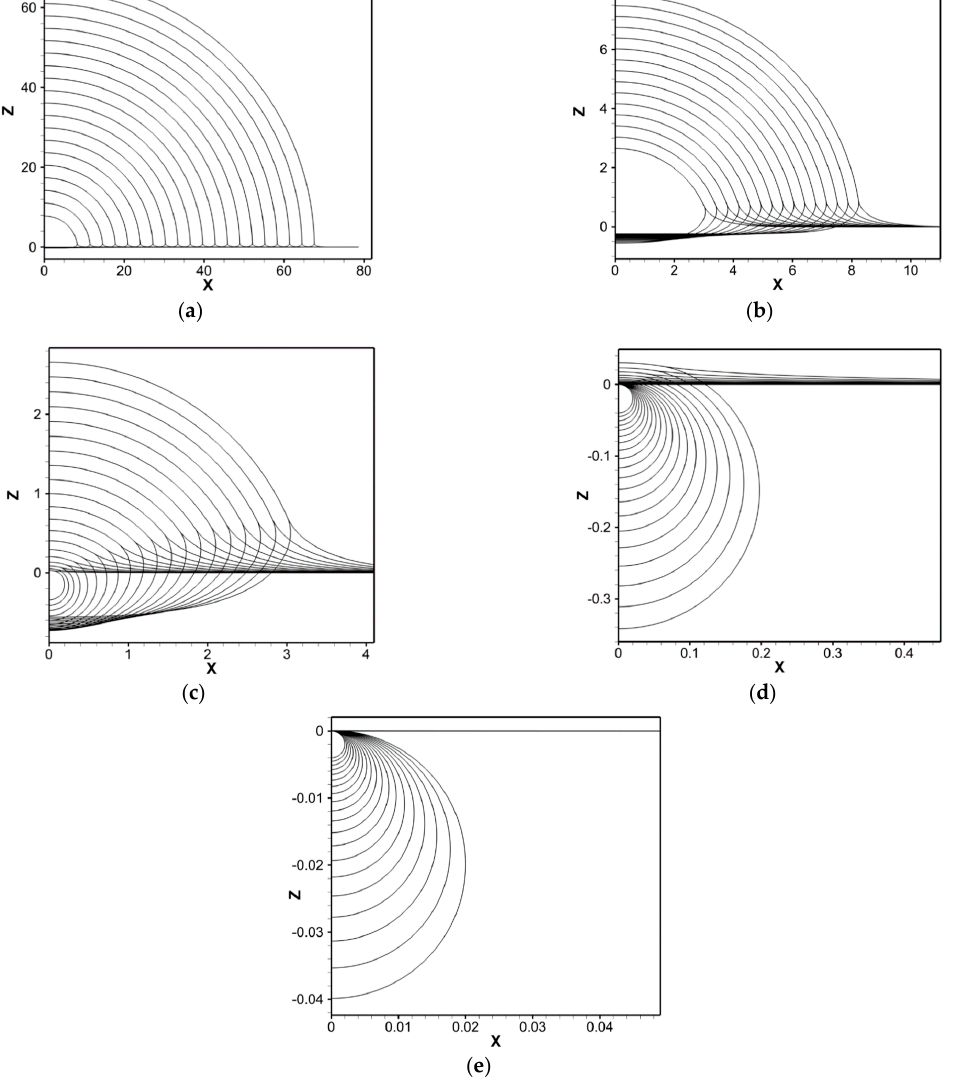
Figure 9. The computed bubble shapes for 10 − 4 < B < 1000, where each shape is drawn at equal intervals on a log scale of B . ( a ) Twenty bubbles for B = 10 − 40 –10 − 4 ( Bo = 5723–83.6 ) . ( b ) Fifteen bubbles for B = 10 − 4 –0.1 ( Bo = 83.6–11.8 ) . ( c ) Twenty bubbles for B = 0.1–10 ( Bo = 11.8–0.076 ) . ( d ) Twenty bubbles for B = 10–100 ( Bo = 0.076–8 × 10 − 4 ) . ( e ) Twenty bubbles for B = 100–1000 ( Bo = 8 × 10 − 4 –8 × 10 − 6 )